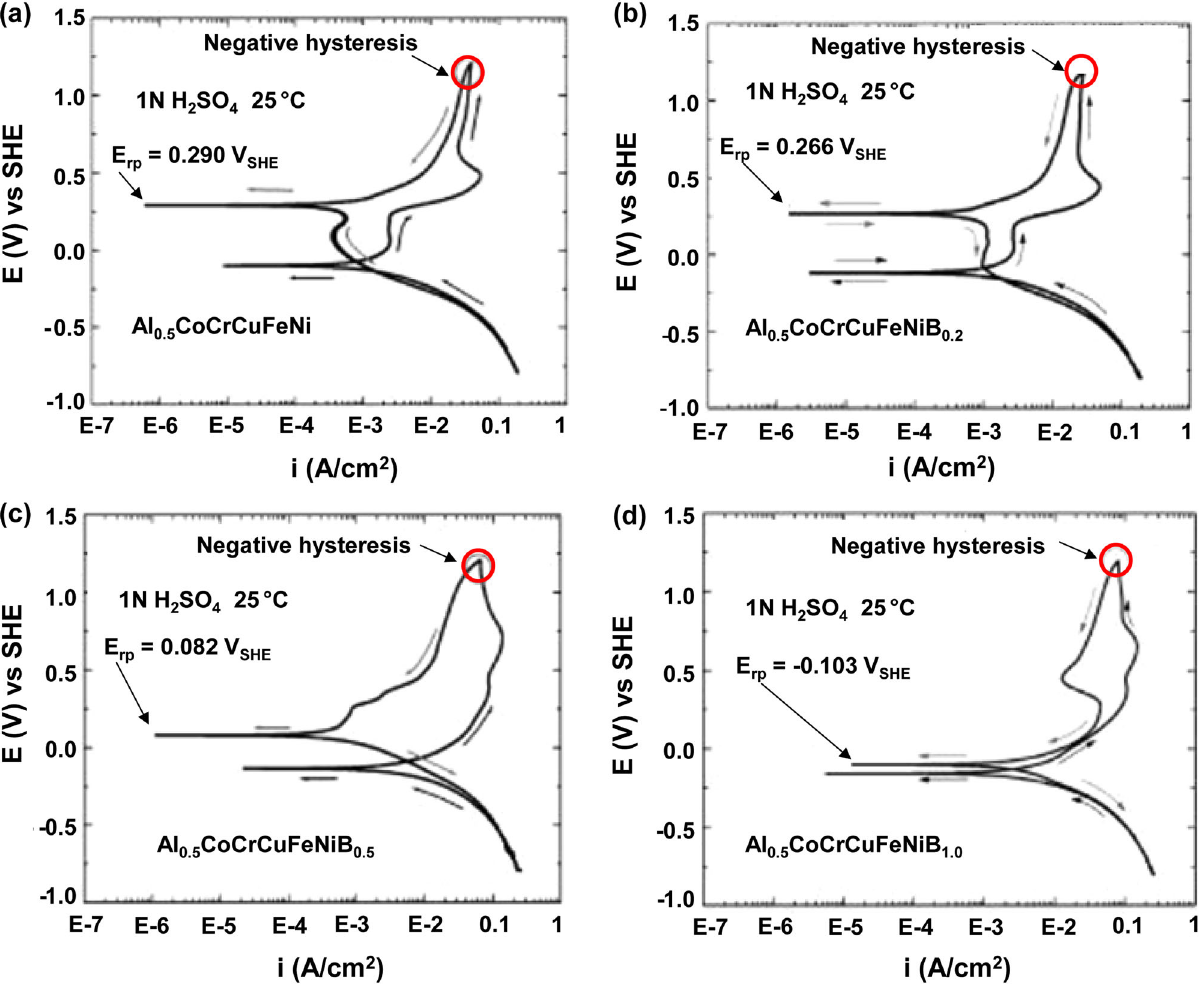
Fig. 12 Cyclic potentiodynamic polarisation curves of the Al 0.5 CoCrCuFeNiB x system with different boron molar ratios: a x = 0, b x = 0.2, c x = 0.6 and d x = 1.0 mol in deaerated 1 N H 2 SO 4 ( a – d reproduced by permission of The Electrochemical Society from ref.